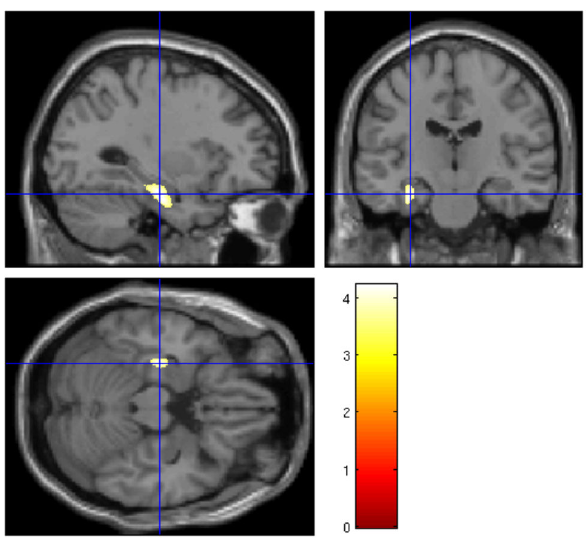
Figure 2. GM volume differences of the hippocampus. Significant difference of GM volume of the hippocampus/ parahippocampal gyrus VOI in subjects with high versus low severity of BPD (cluster peak at x=-30, y=-18, z=-21, k=869, t=.4.22, p=.049 FWE-corrected, threshold of p<.001 uncorrected). doi: